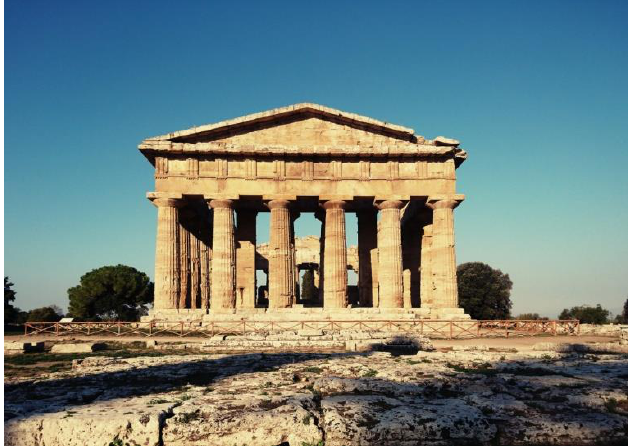
Figure 4. The view of the temple from the east side: the front façade. Copyright © V. Di Marco (Source: Own work CC BY-SA 4.0. Link: https://commons.wikimedia.org/w/index.php?curid=71188205).